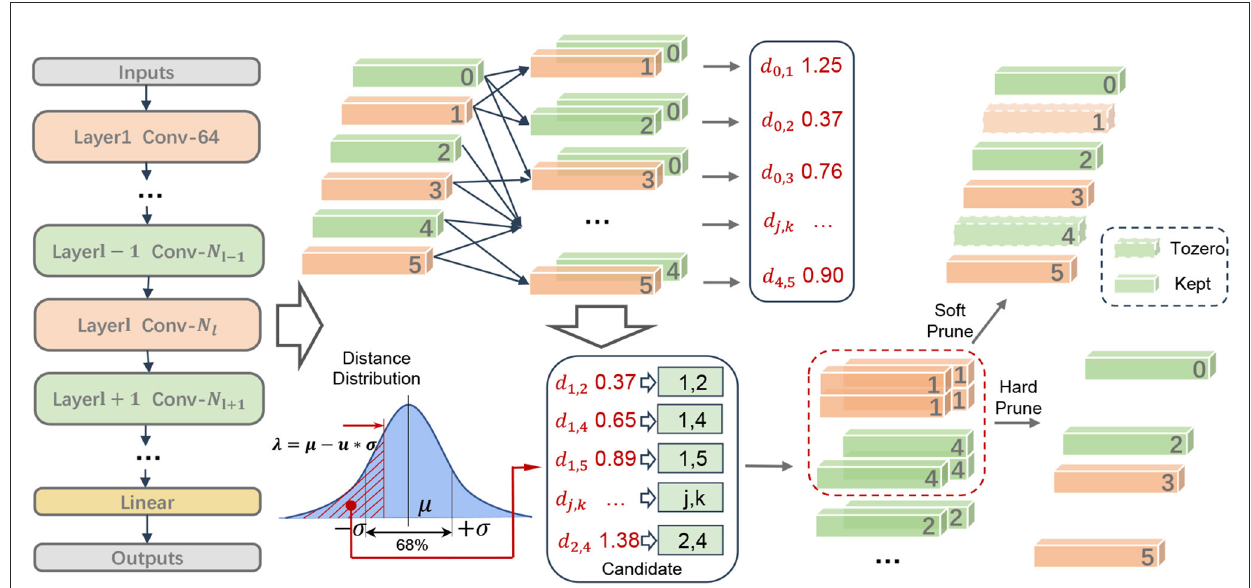
FIGURE1 The pruning diagram of a convolutional layer. First, we compare all the filters in pairs, and then we count the distance set obtained, and put the filters corresponding to the distance value below the soft threshold into the set to be pruned. Finally, the filters with a higher frequency are considered redundant. The two methods of soft pruning and hard pruning are used to deal with redundant